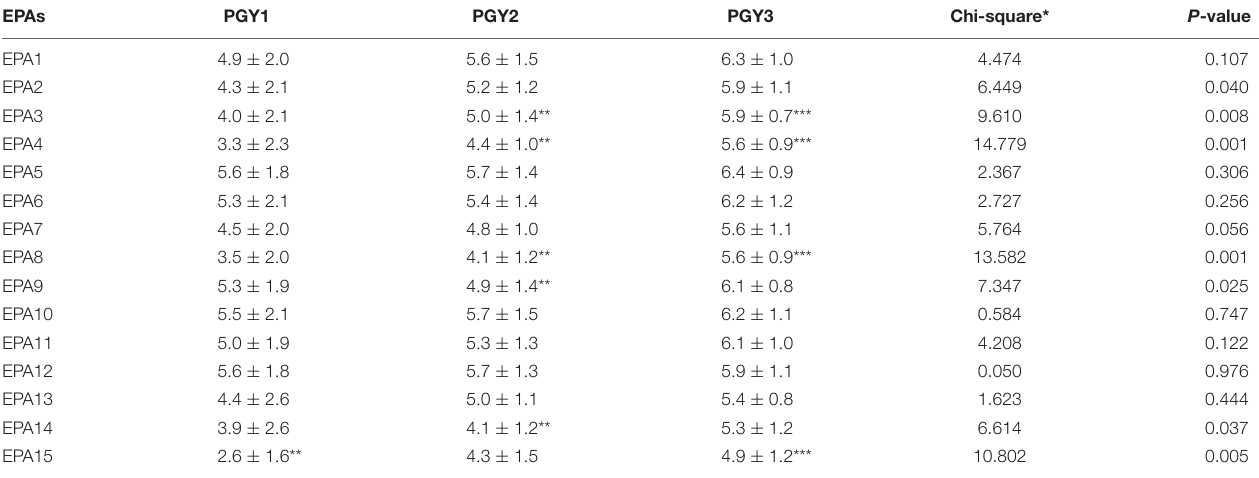
TABLE 7 | Scores of self-assessment in different postgraduate years (PGYs).